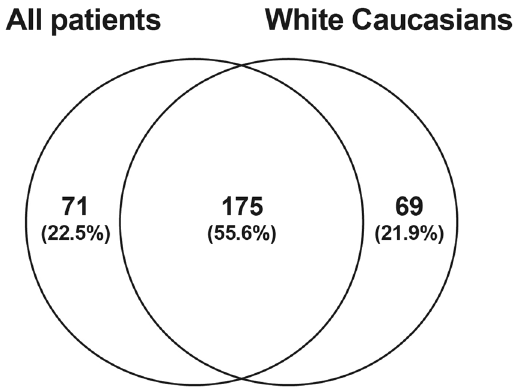
Figure 2. Venn diagram listing shared and unique genes in the ‘all patients’ and ‘white Caucasians’ groups. Percentages of patients are shown in